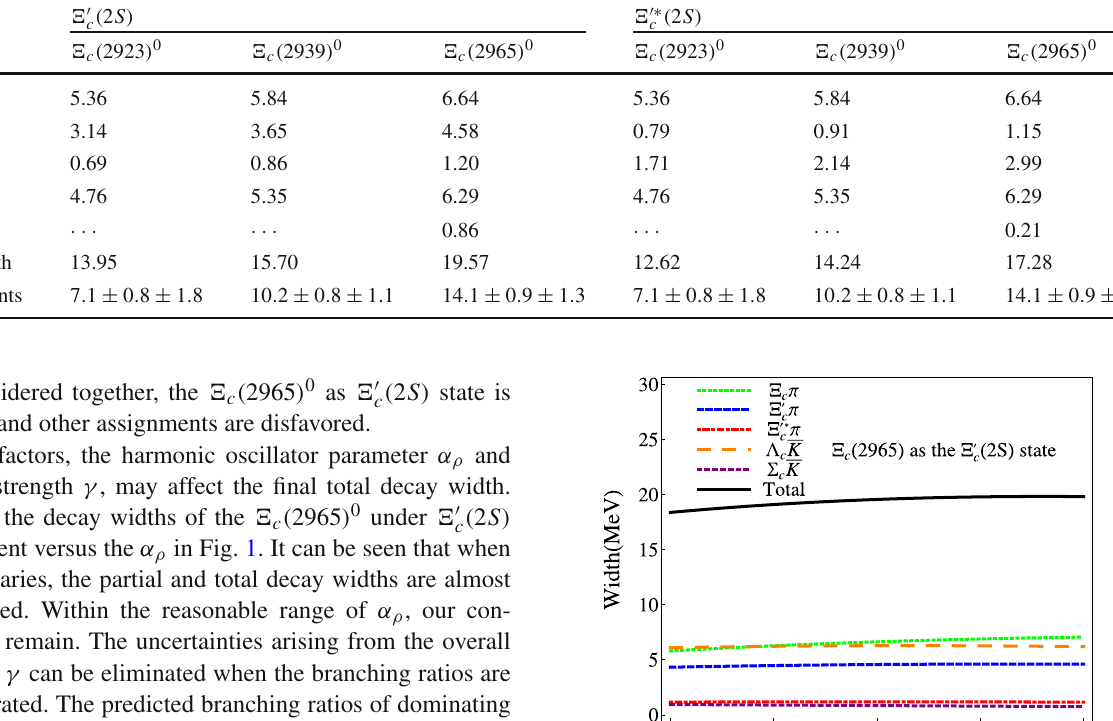
Table 4 Strong decays of the (cid:2) c ( 2923 ) 0 , (cid:2) c ( 2939 ) 0 , and (cid:2) c ( 2965 ) 0 as (cid:2) (cid:2) c ( 2 S ) and (cid:2) (cid:2)∗ c ( 2 S ) states in MeV Mode